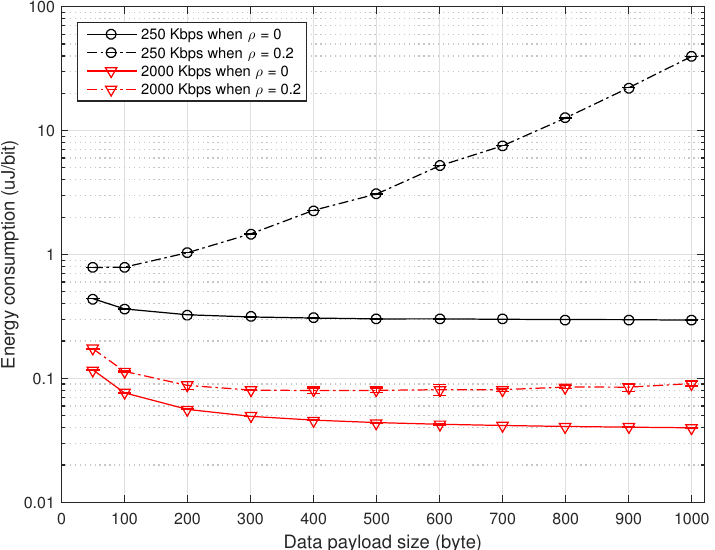
Figure 5. Energy consumption according to the payload size.